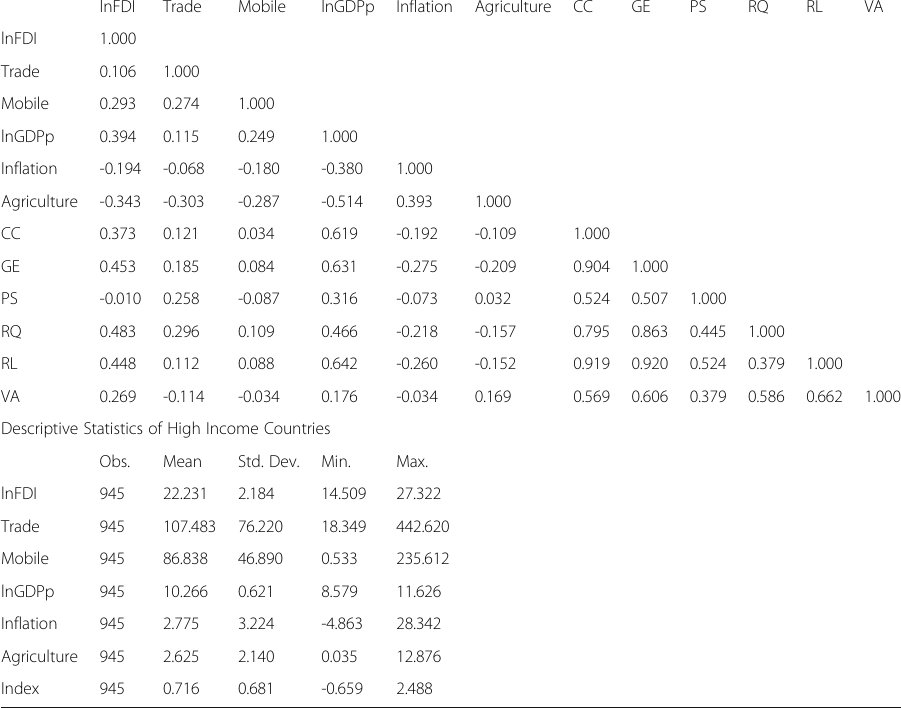
Table 6 Correlation Matrix of High income